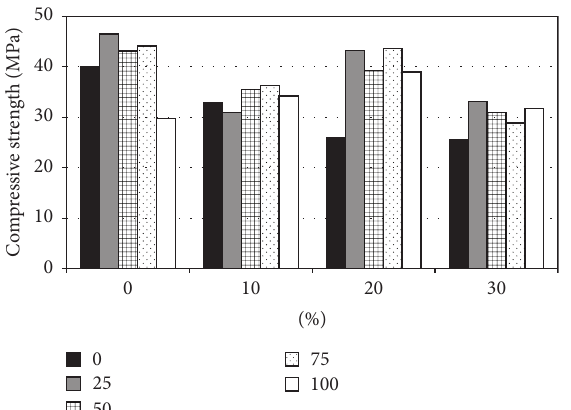
Figure 8: Compressive strength of mortars with FA-UW subjected to freezing cycles.